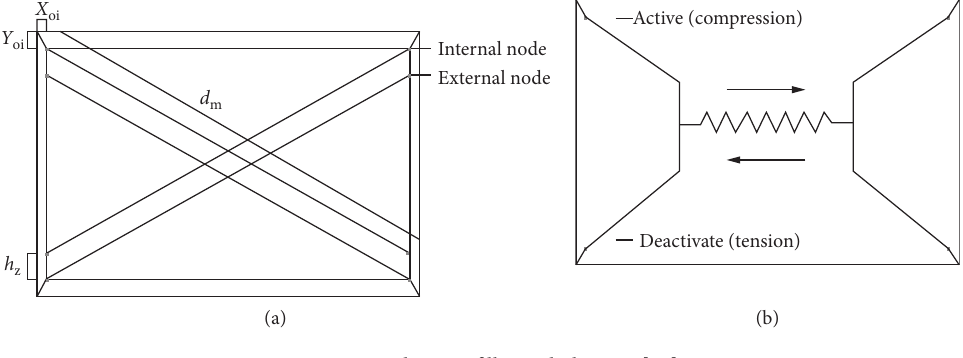
Figure 8: Inelastic infill panel element [29].